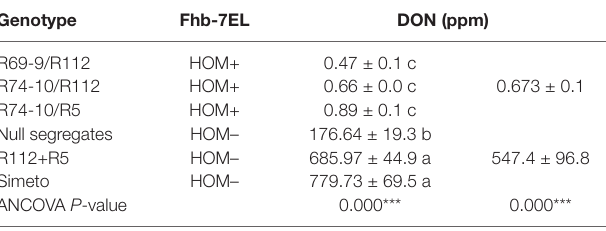
TABLE 6 | Deoxynivalenol (DON) content in wholemeal flour from seeds of infected spikes of carrier (HOM+) and non-carrier (HOM–) genotypes of the Fhb- 7EL